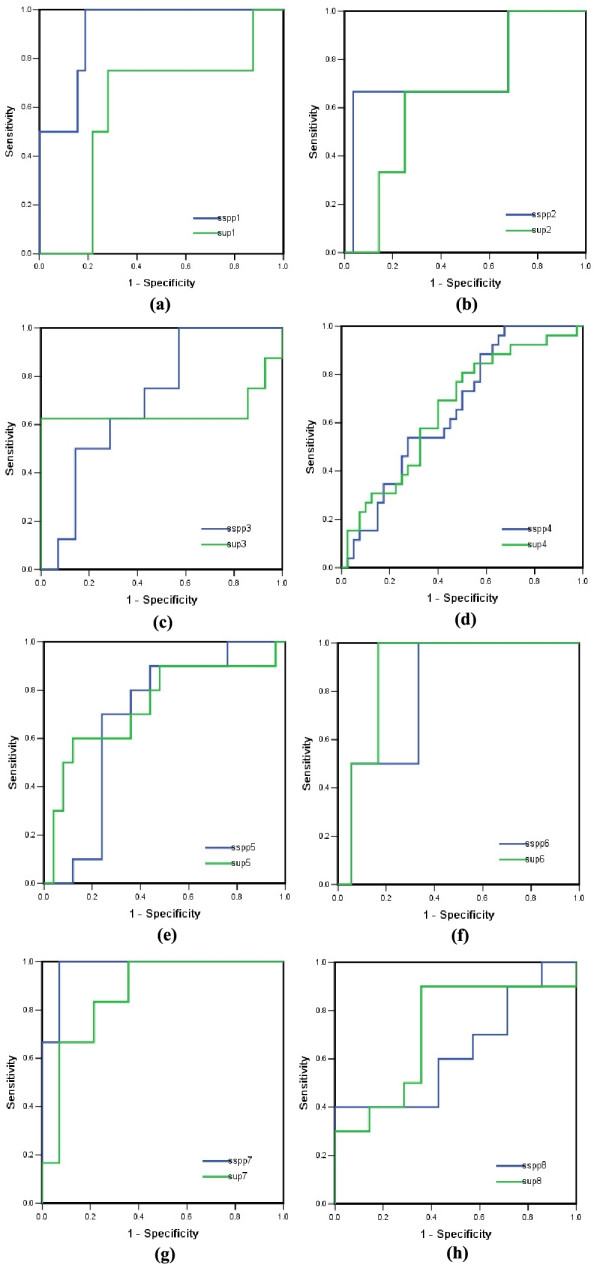
ROC curves for efficacy-predicting neural networks. ROC curves are shown for networks (a) NSSPP1 and NSUP1; (b) NSSPP2 and NSUP2; (c) NSSPP3 and NSUP3; (d) NSSPP4 and NSUP4; (e) NSSPP5 and NSUP5; (f) NSSPP6 and NSUP6; (g) NSSPP7 and NSUP7; (h) NSSPP8 and NSUP8.